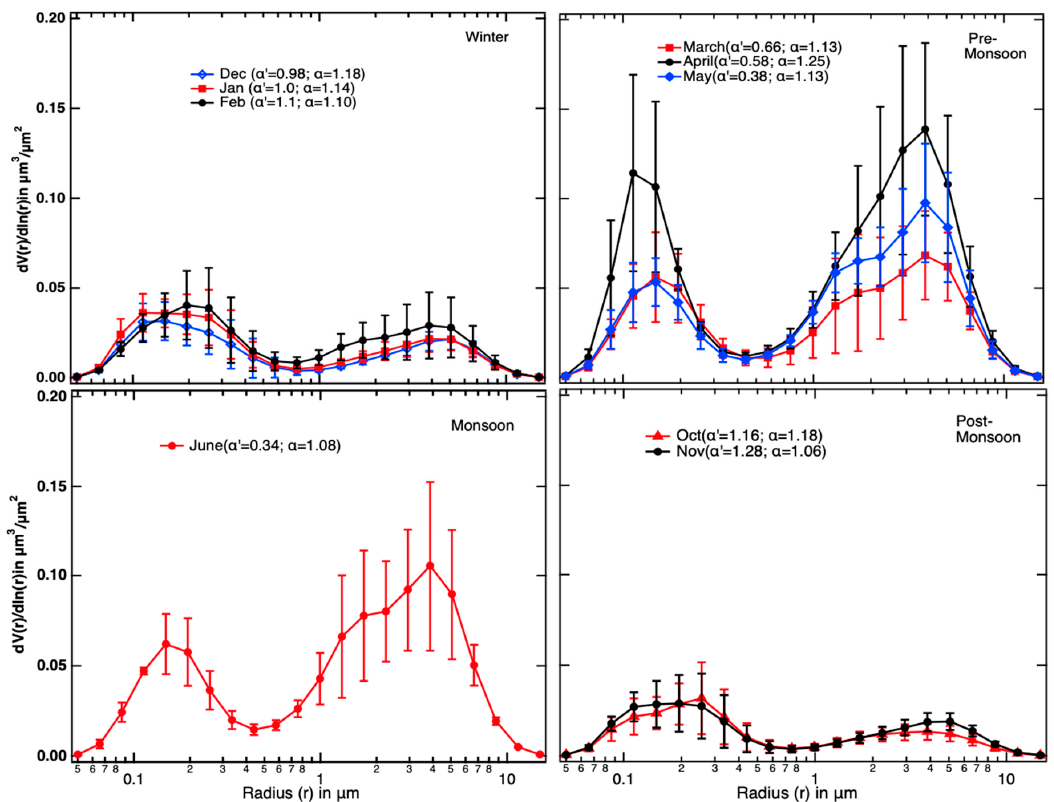
Figure 6. The monthly averaged columnar volume particle size distribution in the range of sizes 0.05 μ m ≤ r ≤ 15 μ m, for different seasons, as indicated.